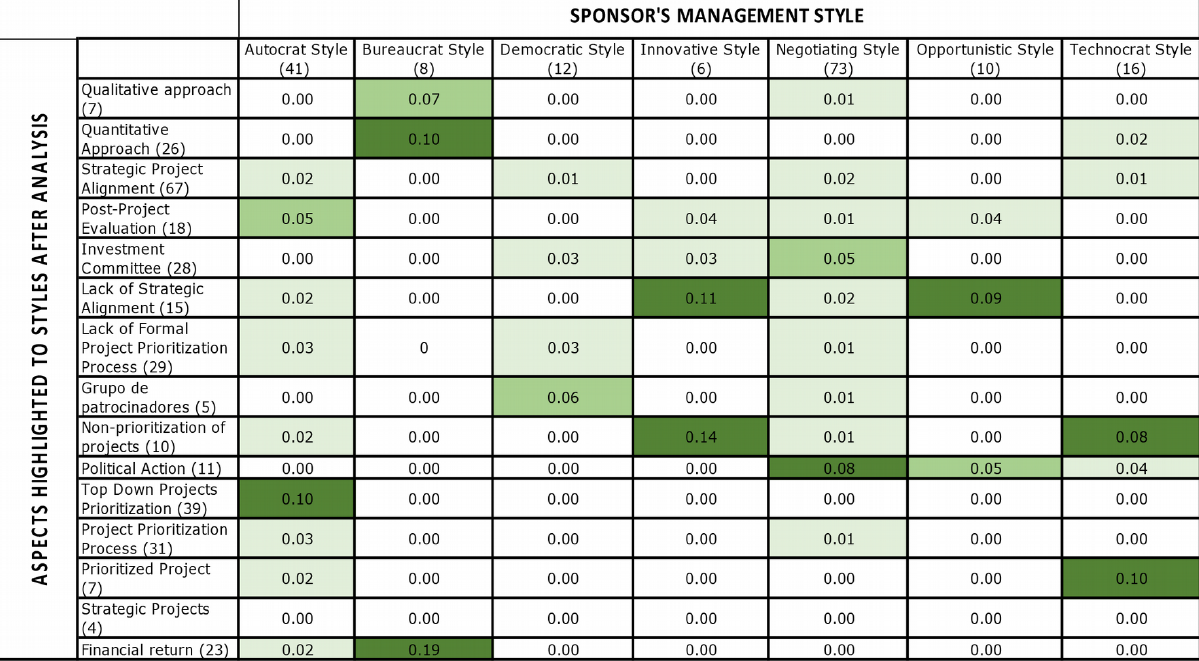
Table 3. Co-occurrence of Management styles and Aspects Highlighted to Styles After